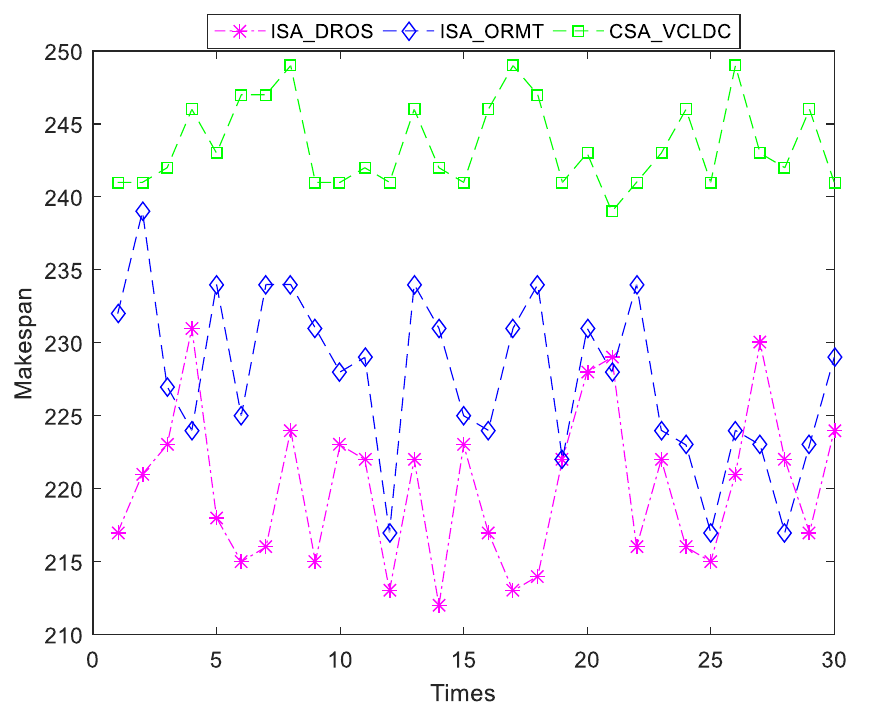
Figure 16. For a random generation example, the completion time obtained by running each algorithm independently for 30 times.